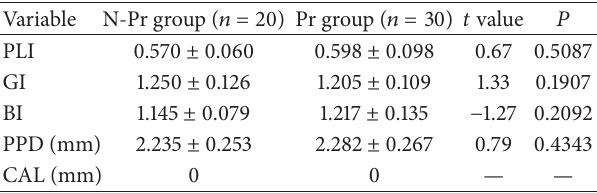
Table 2: Clinical periodontal parameters ( 𝑥 ± 𝑠 ) in the